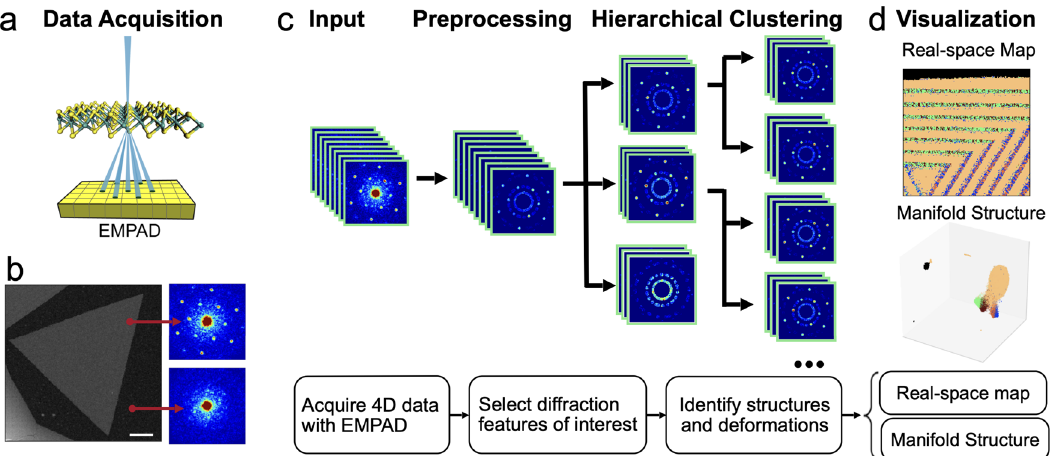
Fig. 1 Schematic of unsupervised learning of 4D-STEM datasets. a Schematic of the EMPAD operation, where a diffraction pattern is recorded at each scanning position. b A 4D dataset that contains a full diffraction pattern at each pixel in the real-space map. Scale bar, 500 nm. c Schematic of the divisive hierarchical clustering work fl ow on diffraction patterns in the 4D data. d Visualization of the clustering results, where the features are mapped back to real space (top) to determine their distribution, and the diffraction patterns are projected onto a lower-dimensional manifold space (bottom) for